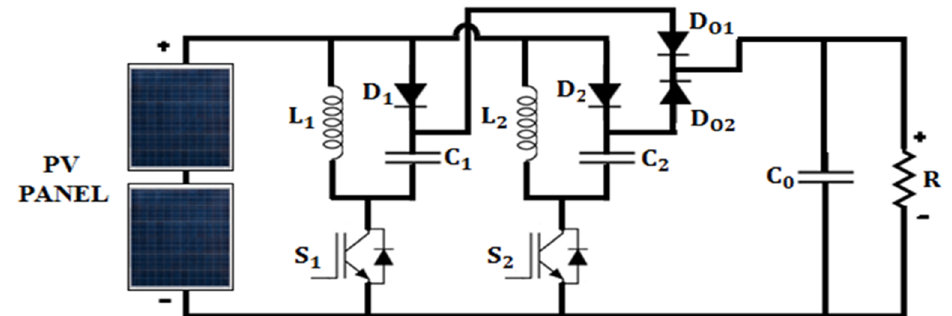
Figure 3. Circuit of the proposed interleaved Luo converter.